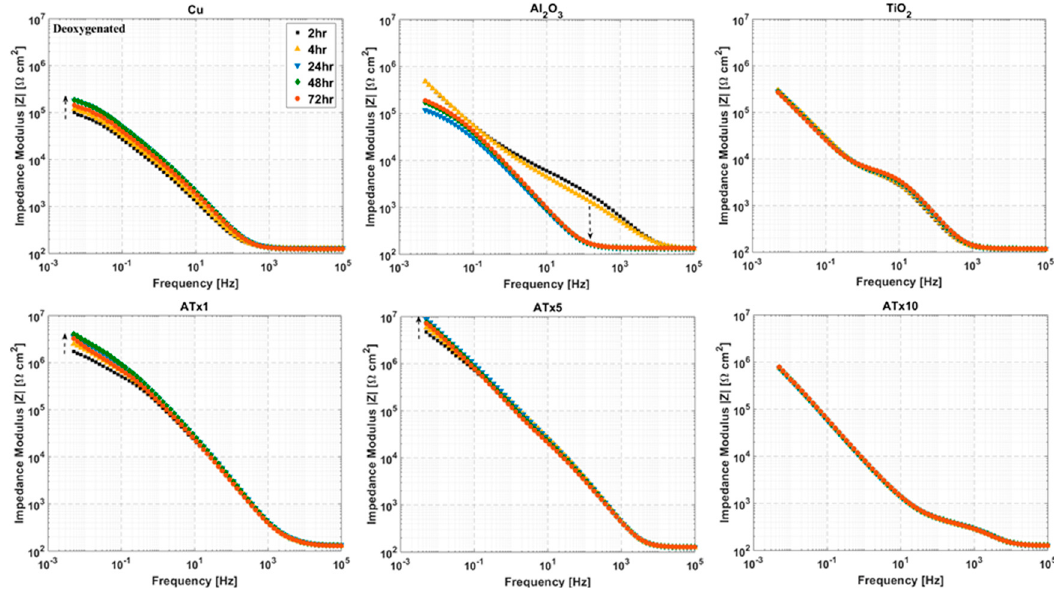
Figure 7. Impedance modulus versus frequency at selected time intervals over 72-h immersion in deoxygenated 0.1 M NaCl. Frequency range is 100 kHz to 5 mHz and sample type is given above each plot. Dashed arrows indicate increasing immersion time. Refer to Table 1 for sample descriptions.